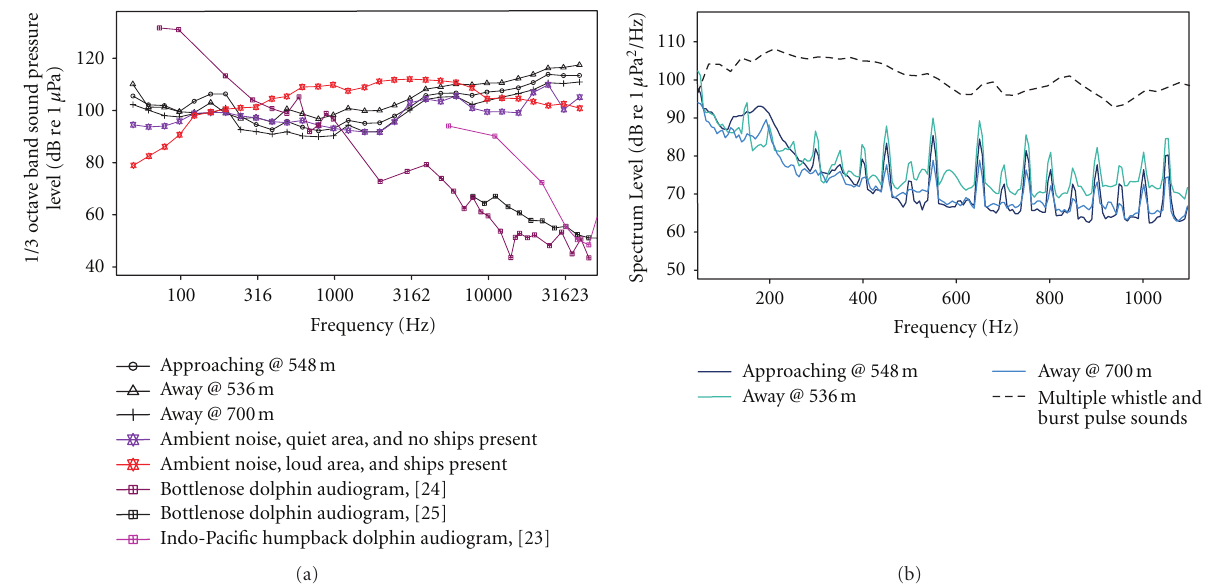
Figure 5: (a) The various sound pressure level contributions of a Hi-Speed Ferry (R101), at Northeast Lantau Station number 1 with a Beaufort sea state of 2. The ambient noise level (represented in purple) was taken from Northwest Lantau number 1, an area with very little boat tra ffi c, located within the Sha Chau and Lung Kwu Chau Marine Park. The red indicates the South Lantau Vessel Fairway (SLVF), a busy tra ffi c area, especially for ferries. SLVF was recorded with several ferries and a shrimp trawler present during a Beaufort sea state of 0. (b) shows selected sound spectra of the above high-speed ferry in comparison to the spectra of humpback dolphin communication sounds at a distance of ≤